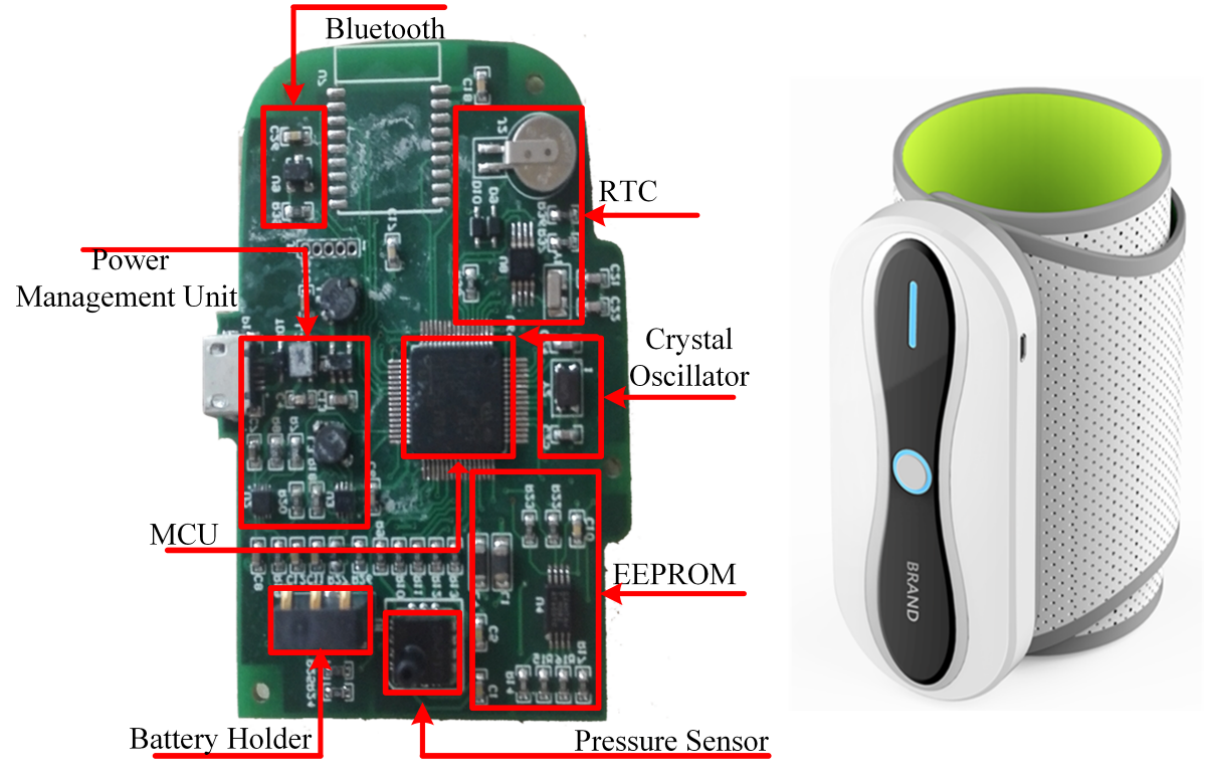
Figure 2. Printed circuit board display of the new ambulatory blood pressure monitor device. RTC: real-time clock; MCU: microcontroller